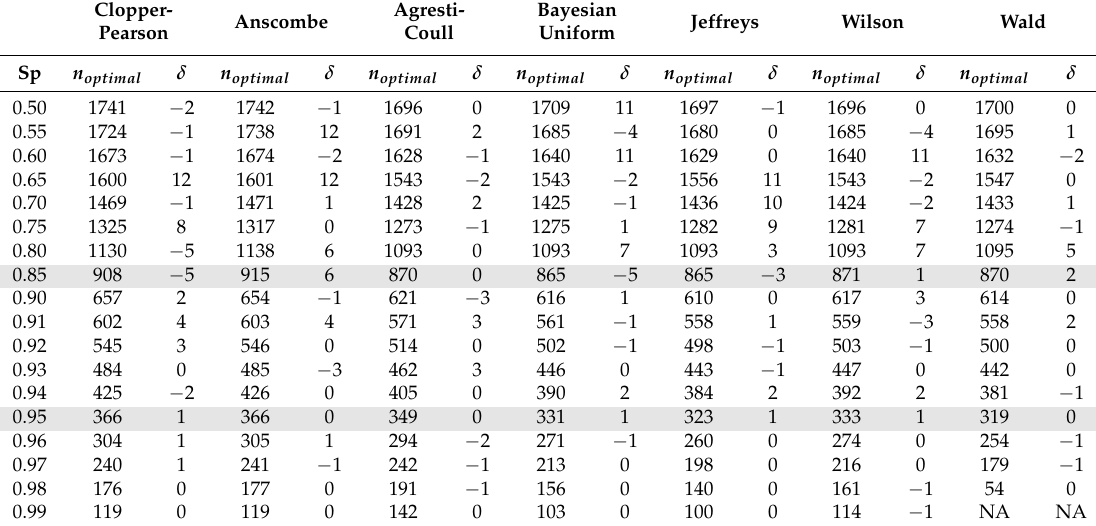
Table 2. Optimal sample sizes ( n optimal ) corresponding to several specificities, and differences between the optimal and approximate ( n aprox ) sample sizes, δ = n optimal − n aprox , admitting η = 0.10, ω = 0.05, ξ = 10 − 4 , and 95% nominal confidence